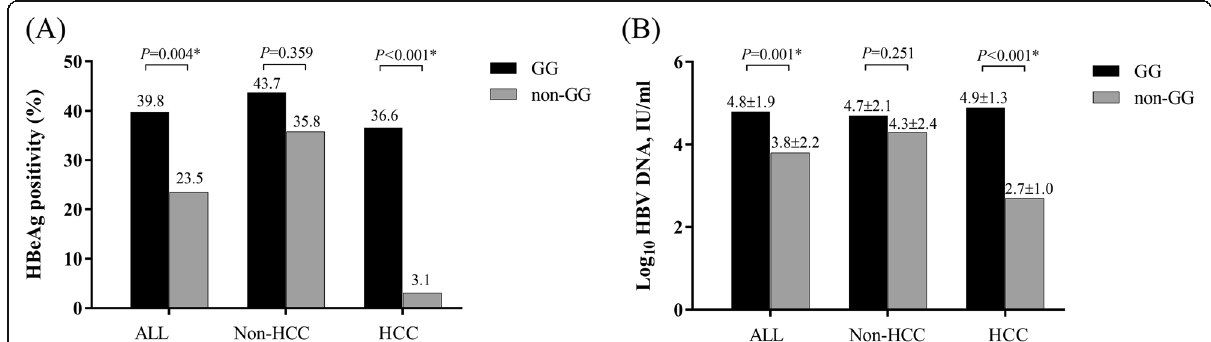
Fig. 1 Viral markers in patients with CHB regarding rs2296651 genotypes ( a ) rates of HBeAg positivity ( b ) mean HBV DNA